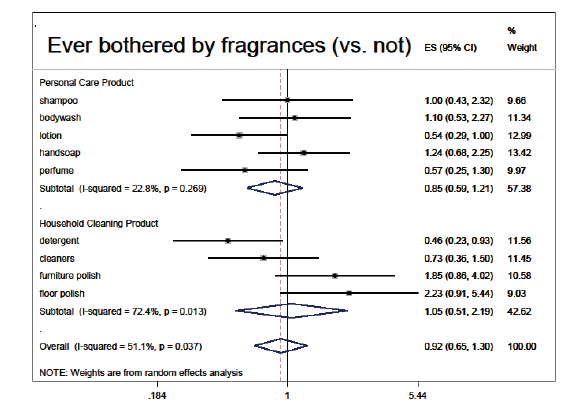
Figure 2. Demographic predictors of fragranced product use (meta-analysis of